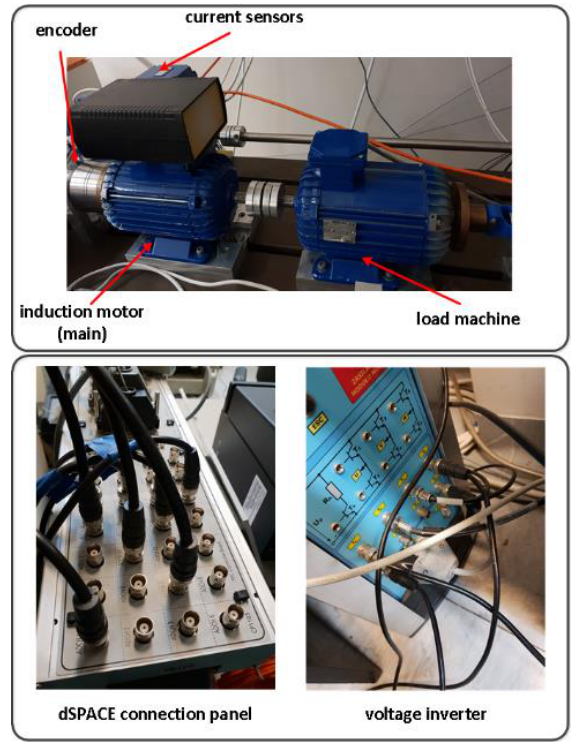
Figure 9. Elements of laboratory equipment.